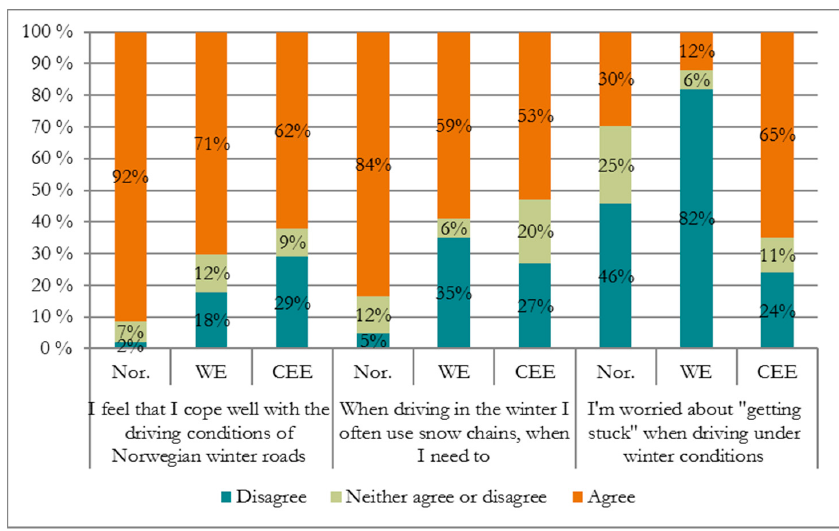
Figure 4. National groups’ distributions on three questions on feeling of mastery related to winter driving, snow chain use and perception of risk of “getting stuck” while driving under winter conditions. Percentage of Norwegian (Nor.) (N = 61), Western European country (WE) (N = 17), Central/Eastern European country (CEE) (N = 45).